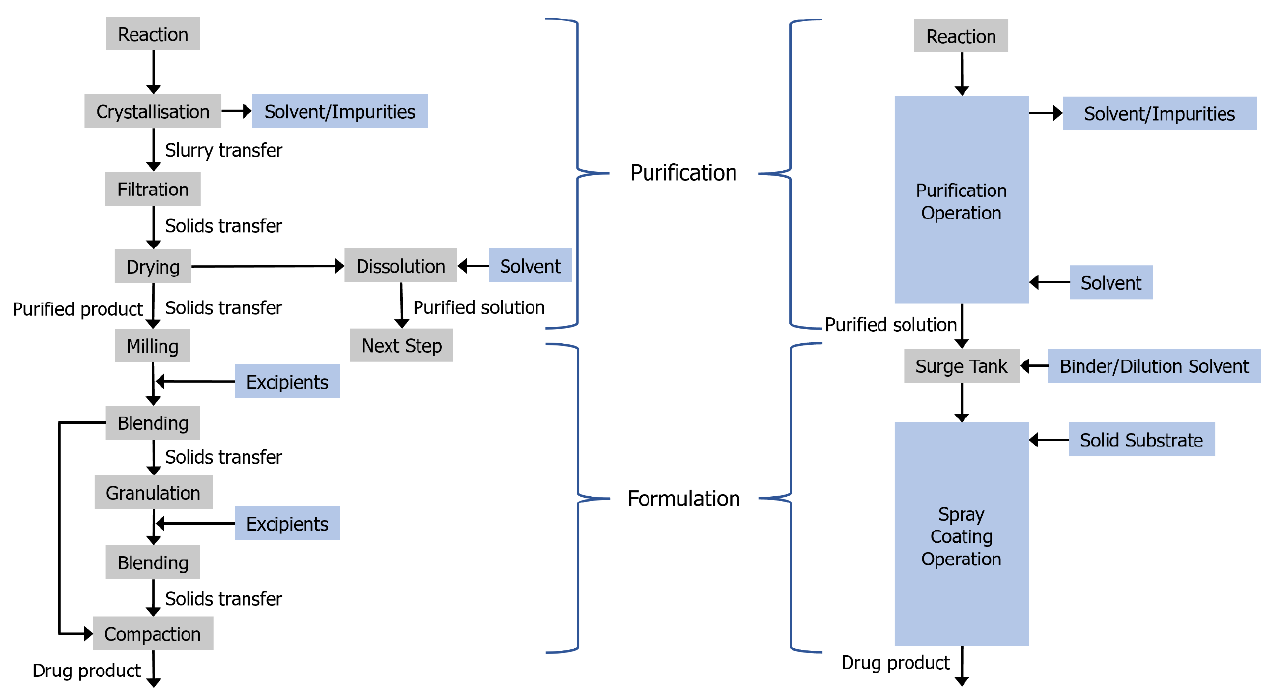
Figure 1. Schematic representation of the slurry- and powder-free manufacturing scheme afforded by utilizing isolation-free manufacturing techniques. Adapted with permission from Ref. [21]. 2016, American Chemical Society.